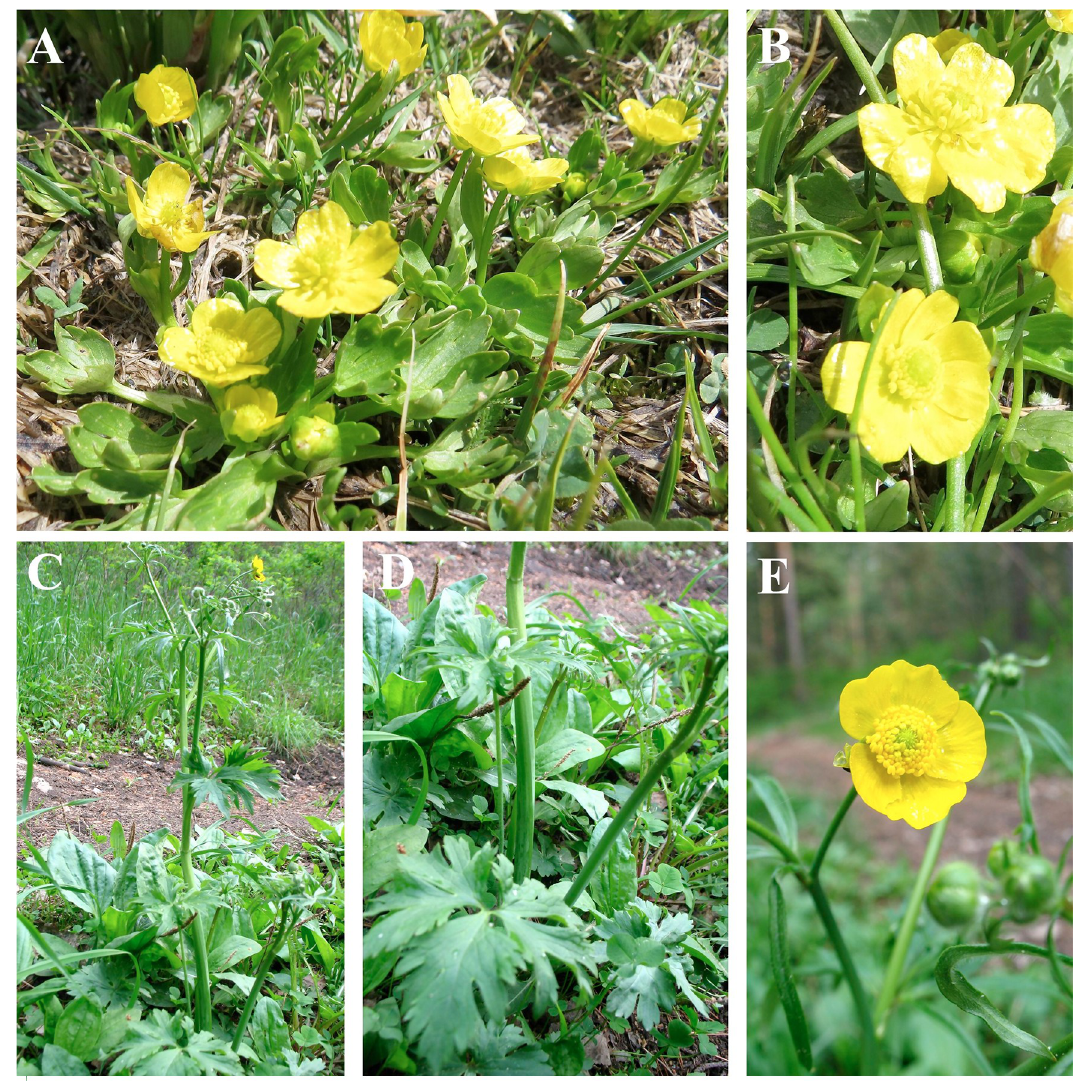
Fig 2. Habitus of R . talassicus (A and B) and R . karkaralensis (C, D, and E) collected in Kazakhstan.